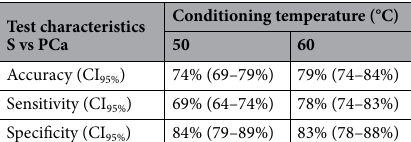
With the same specificity, eNose sensitivity is significantly improved for headspaces conditioned at 60 °C (i.e., 78%(CI 95% 74–83%)) than ones enriched at 50 °C (i.e., 69%(CI 95% 64–74%)). Based on results achieved, the proposed experimental protocol foresees the enrichment of static headspaces at 60 °C. Repeatability of eNose responses among different subjects. Given the variability of urine samples not only among subjects, but also among different samples from the same subject, the repeatability of the pro- posed experimental protocol was evaluated. For a subset of the population involved in the study, different urine samples (first portion of the urination) were collected on different days and analysed by eNose, according to the defined experimental procedure. This investigation aimed to study the influence of diet, physical activity or any other factor that may have affected urine composition on eNose capability to correctly recognized samples from the same subject and discriminate PCa patients from control. No exclusion criteria, concerning dietary habits, smoking, taking medications were applied. Moreover, no strict rules about the hour of the collection was fixed. Figure 3a reports the Principal Component Analysis (PCA) score plot relevant for those analyses, which enables a visual inspection of multidimensional datasets. The score plot, reporting the projection of samples into a new coordinate system, defined by principal components (i.e., a linear combination of signals provided by different sensors), provides information about data similarities and can be used to investigate the existence of trends or grouping among samples. Samples from the same subject cluster in the same area of the plot, proving that the proposed experimental protocol is robust, and that results are not affected by the intrinsic variability of urine samples. Indeed, the distance among points in a PCA score plot is inversely proportional to their similarities 55 . This result confirmed that no exclusion criteria are needed to ensure good classification performances, as it was suggested by Taverna et al. 35 . Prostate cancer diagnosis. Data relevant to the analysis of urine headspaces enriched at 60 °C were organized in a dataset, consisting of 164 samples (110 PCa patients and 54 controls), and the data processing procedure, described in Materials and Methods, was applied to build the diagnosis model. Among the 150 fea- tures considered, the feature selection by Boruta identified 37 features (transient and steady-state) as relevant for the discrimination of samples from controls and PCa patients, which were used to build the classifier by randomForest. Figure 3b reports the PCA score plot relevant to PCa diagnosis model. Samples belonging to dif- ferent class clustered in different region of the plot, highlighting the potentialities of eNose to distinguish PCa samples from controls. Most of the control samples (blue circle) distributed in the right portion of the plot, even though some outliers were present, while the PCa samples (red circle) distributed mainly in the left region of the plot. The innovative diagnostic tool based on urine odour analysis by eNose and the above-described analysis protocol achieved an accuracy of 83% (CI 95% 77–89), with a sensitivity of 82% (CI 95% 73–88) and a specificity of 87% (CI 95% 75–94). The results of the 10-fold cross validation are summarized in Table 2.